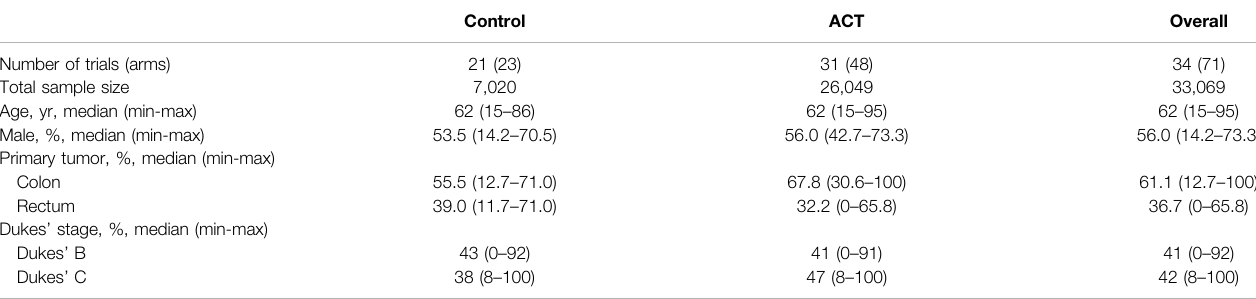
ACT, indicates adjuvant chemotherapy; Control, indicates surgery alone.